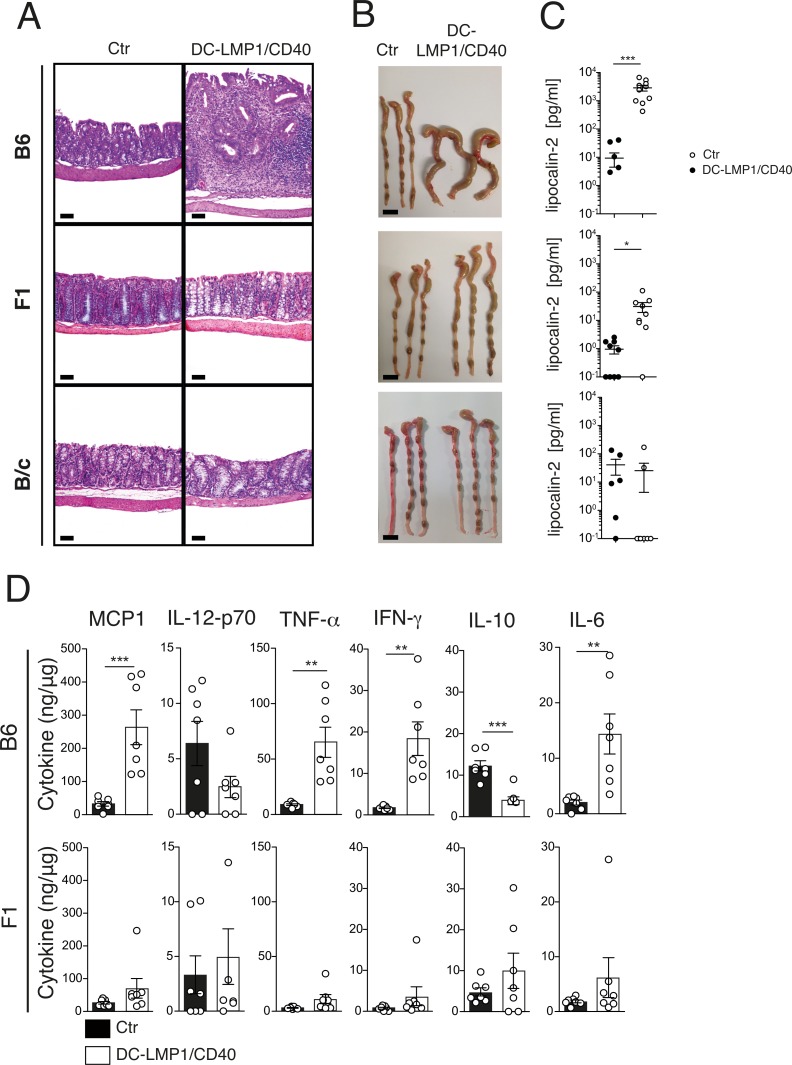
Graded colitis development in DC-LMP1/CD40 mice.(A) B6DC-LMP1/CD40 mice show severe colitis with a thickening of the colon mucosa, extensive proprial infiltration of mixed inflammatory mononuclear cells, loss of crypts and reduction of goblet cells. F1 and B/cDC-LMP1/CD40 mice show no changes in comparison to controls (Ctr). Paraffin sections, HE-staining. Bars = 100μm. (B) Colon pictures from Ctr and DC-LMP1/CD40 animals on different genetic backgrounds. Bars = 1 cm. (C) Levels of fecal lipocalin-2 as measured by ELISA in 8-10-week-old DC-LMP1/CD40 animals on different genetic backgrounds. Shown is pooled data from 3 experiments (n = 6–10). (D) Levels of pro-inflammatory cytokines were measured in colon homogenates from 8-12-week-old B6 and F1DC-LMP1/CD40 mice. Cytokine concentrations were measured with a Cytometric Bead Array (CBA) kit and normalized to the total protein content for each sample. Shown are data from 2 pooled experiments with similar outcome (n = 7). All bar graphs represent mean ± SEM and statistical significance was analyzed using a student´s t-test, with *: P < 0.05, **: P < 0.01 and ***: P < 0.001.